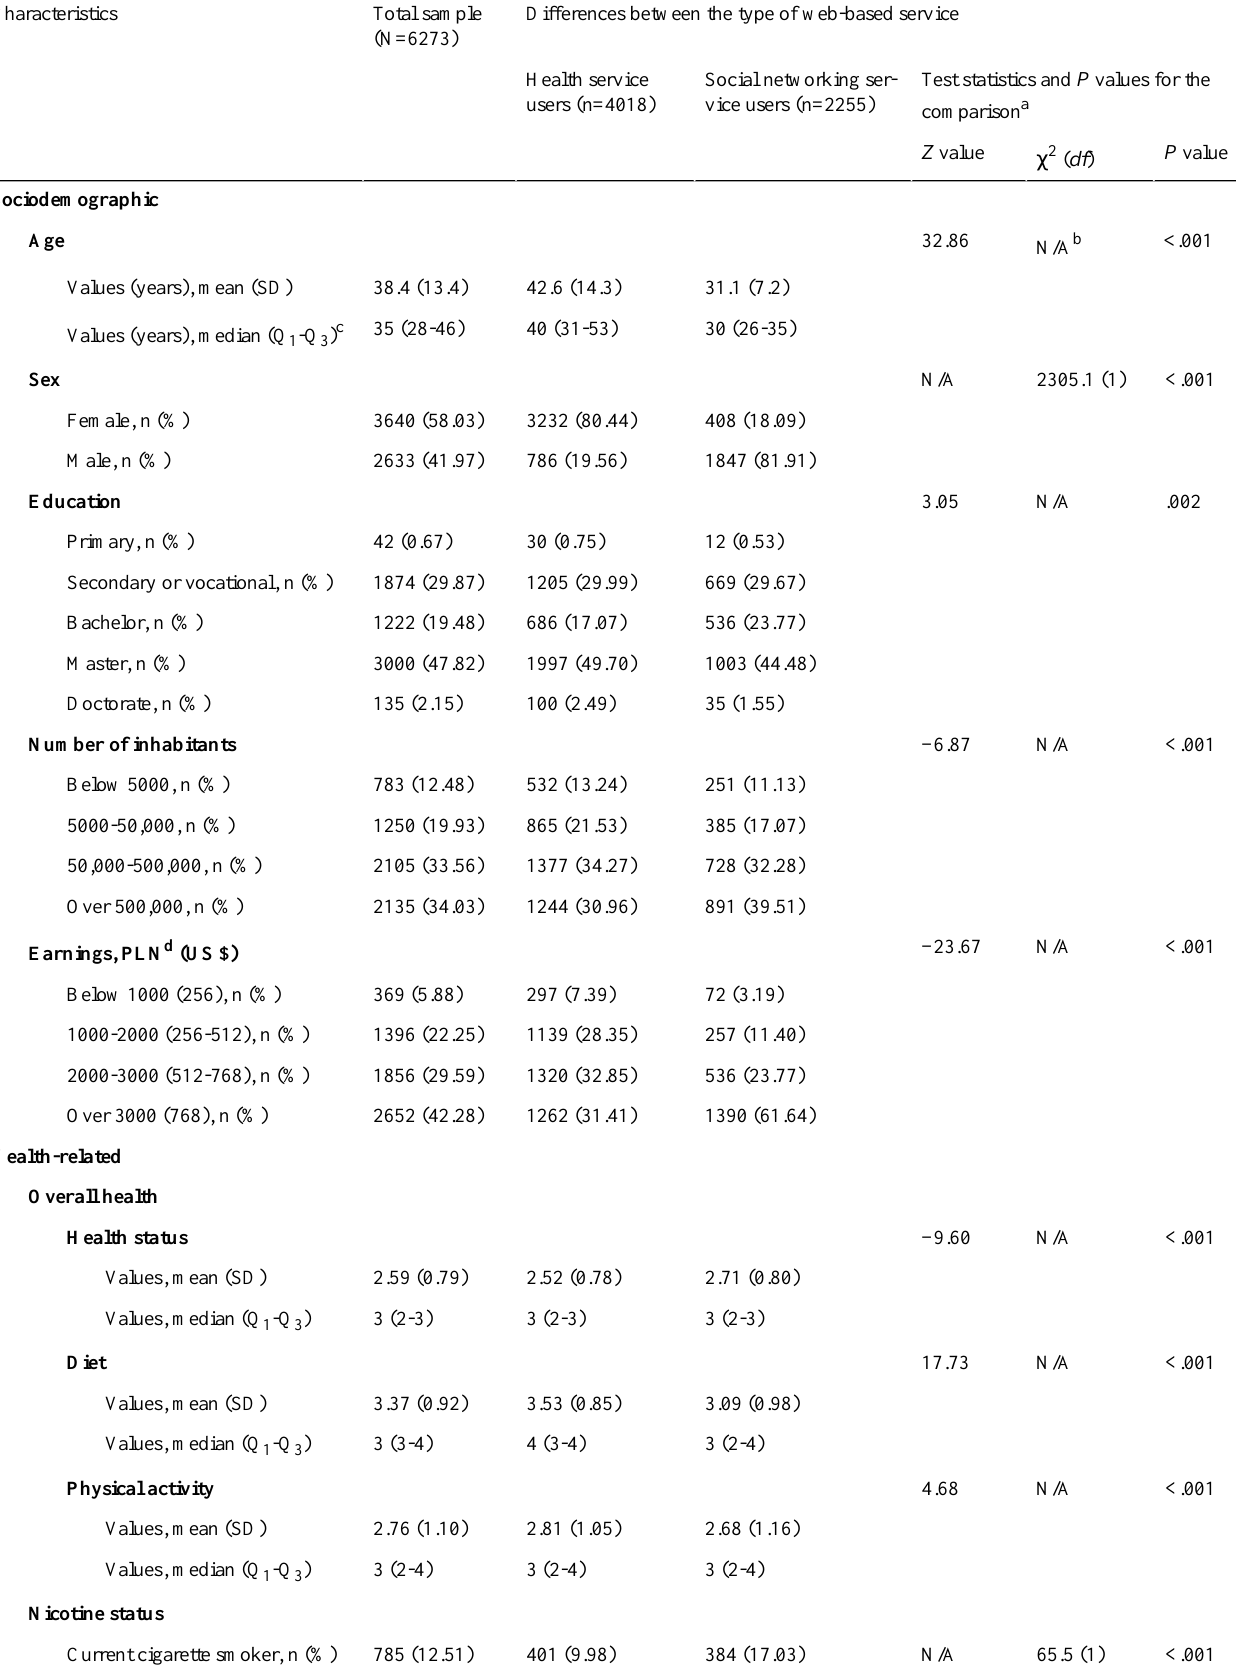
Table 1. Sociodemographic characteristics, health-related characteristics, and dietary supplement–related characteristics of the study participants. Data for the total sample and the comparison of participant characteristics from different web-based services are